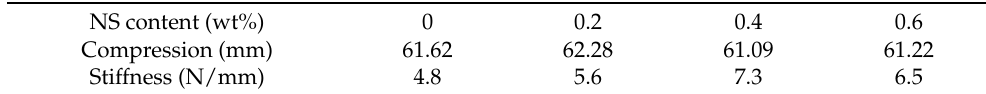
Table 1. Compression properties of helical